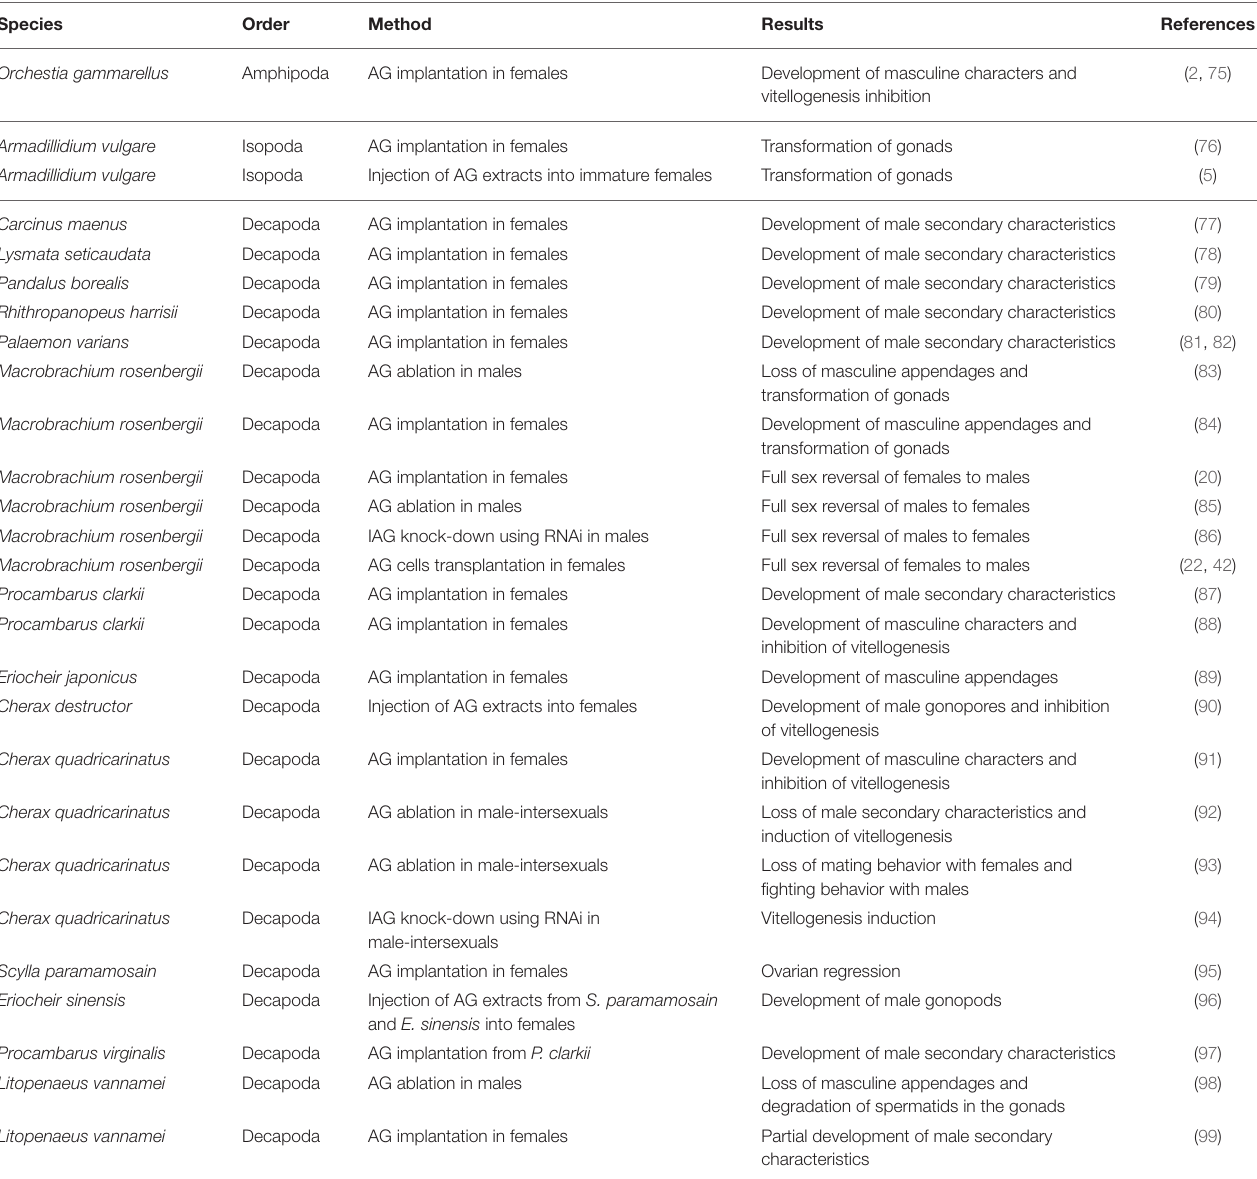
TABLE 2 | Summary of experiments that included IAG-switch based manipulations in